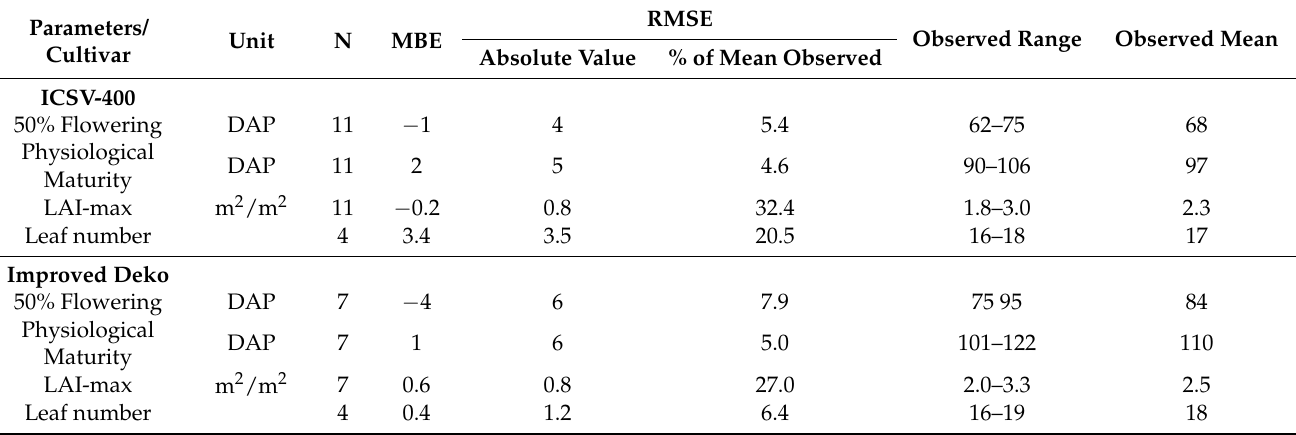
Table 5. Statistical evaluation of simulated phenology and morphological traits (LAI and total leaf number/plant) of contrasted sorghum cultivars calibrated from experiment conducted under optimum conditions in Southern Guinea and Sudan Savannah